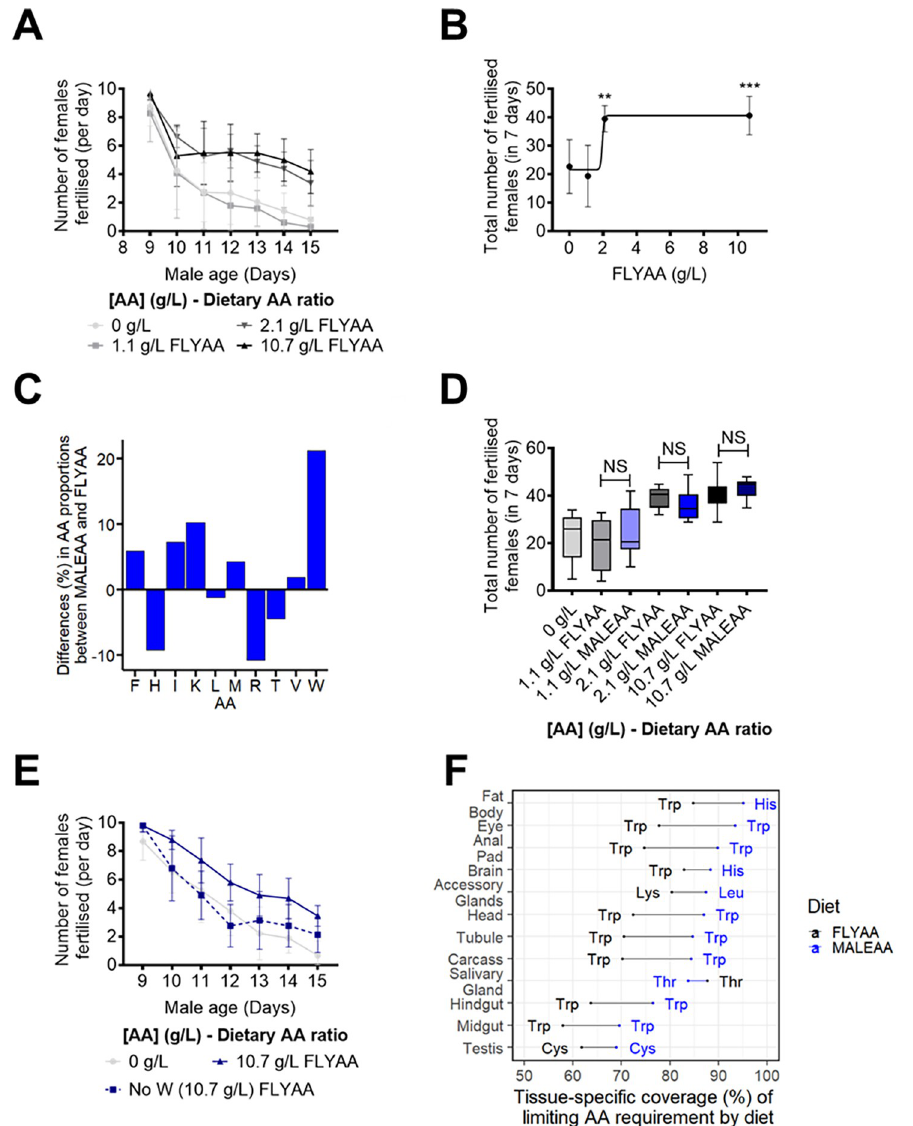
Fig 2. Male fecundity is modified by dietary AA concentration but not ratio. (A). The number of virgin female flies successfully fertilised by individual males during our seven-day assay. Male fecundity was reduced by decreasing dietary AA concentrations. AAs were provided in the exome matched proportion, FLYAA). Error bars represent the standard deviation. (B). The change in the cumulative number of females fertilised by males in response to dietary AA change could be modelled by a sigmoidal dose-response curve (R 2 = 0.537; least-squares fit). ( ��� = P < 0.001, in comparison with 0 g/L). Error bars represent the standard deviation. (C). Predicted difference in each essential AA when comparing the male transcriptome matched proportions (MALEAA), and the exome matched proportions (FLYAA). A positive difference indicates that the AA is more abundant in MALEAA than in the FLYAA. MALEAA should cover any essential AA deficiency of FLYAA, and thus, the relative increase in the concentration of the most limiting essential AA (Tryptophan, W, 20%) equals the potential increase in fecundity that could be achieved for flies fed with MALEAA. (D). Males fed with a diet containing a transcriptome (MALEAA) matched AA proportion did not differ from those fed the exome matched (FLYAA) diets for any concentration of AAs tested. Error bars represent the standard deviation. (E). The effect of tryptophan dropout from the diet on the daily capacity of males to fertilise females during a seven-day period. The removal of tryptophan from the diet caused a fast decay in fertilisation that matched that caused by the removal of all AAs. AAs were provided in the male transcriptome matched proportion, MALEAA. Error bars represent the standard deviation. (F). Coverage of the predicted dietary AA requirements by MALEAA and FLYAA when compared to the transcriptome weighted exome match proportion from each tissue in male flies. For each tissue, the x-axis displays the degree to which the limiting AA demand is met by the diets MALEAA (blue) and FLYAA (black). The closer to 100%, the better the diet covers the predicted tissue demand